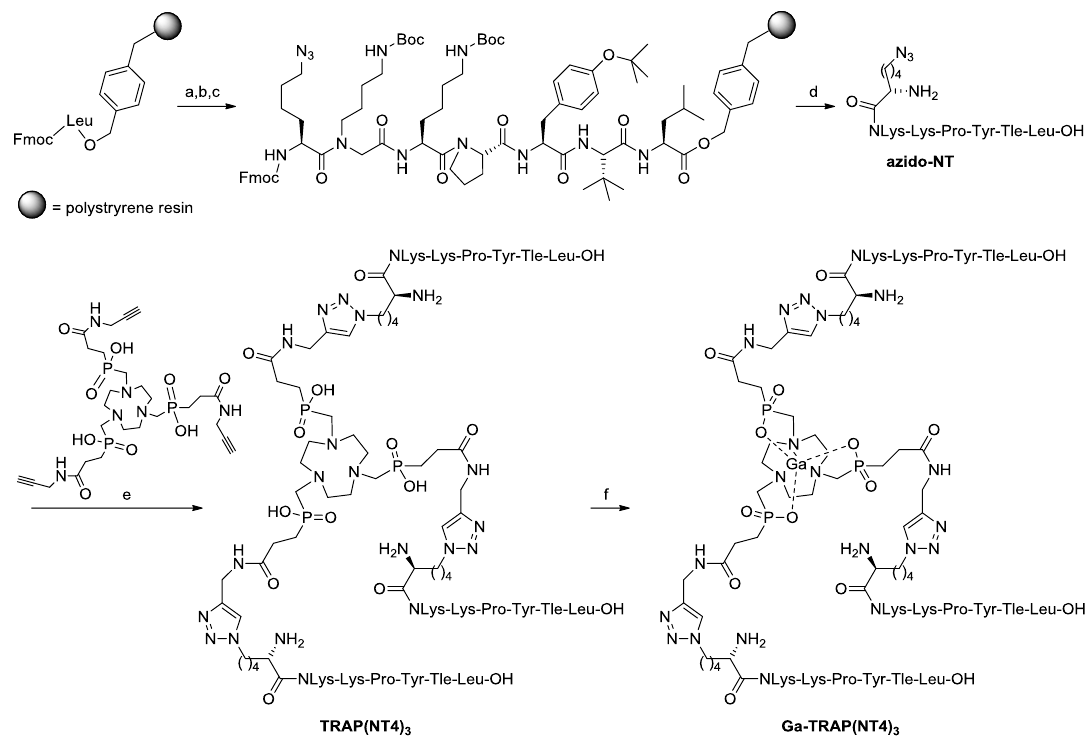
Figure 1. Synthesis of Ga-TRAP(NT4) 3 , reagents and conditions: ( a )